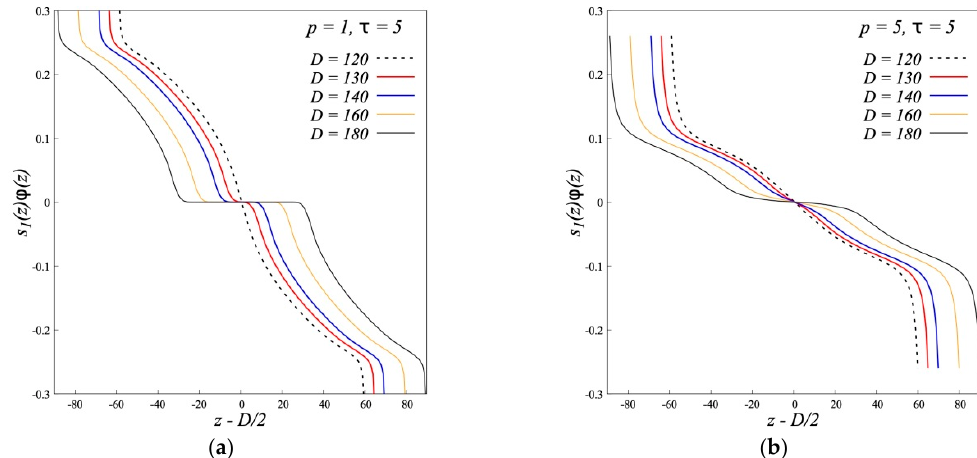
Figure 14. The segment orientation profile s 1 ( z ) φ ( z ) = φ ( z , + 1) − φ ( z , − 1) of two opposing dipolar brushes in the case of flexible ( p = 1) ( a ) and rigid ( p = 5) ( b ) polymer chains ( N = 200, σ =